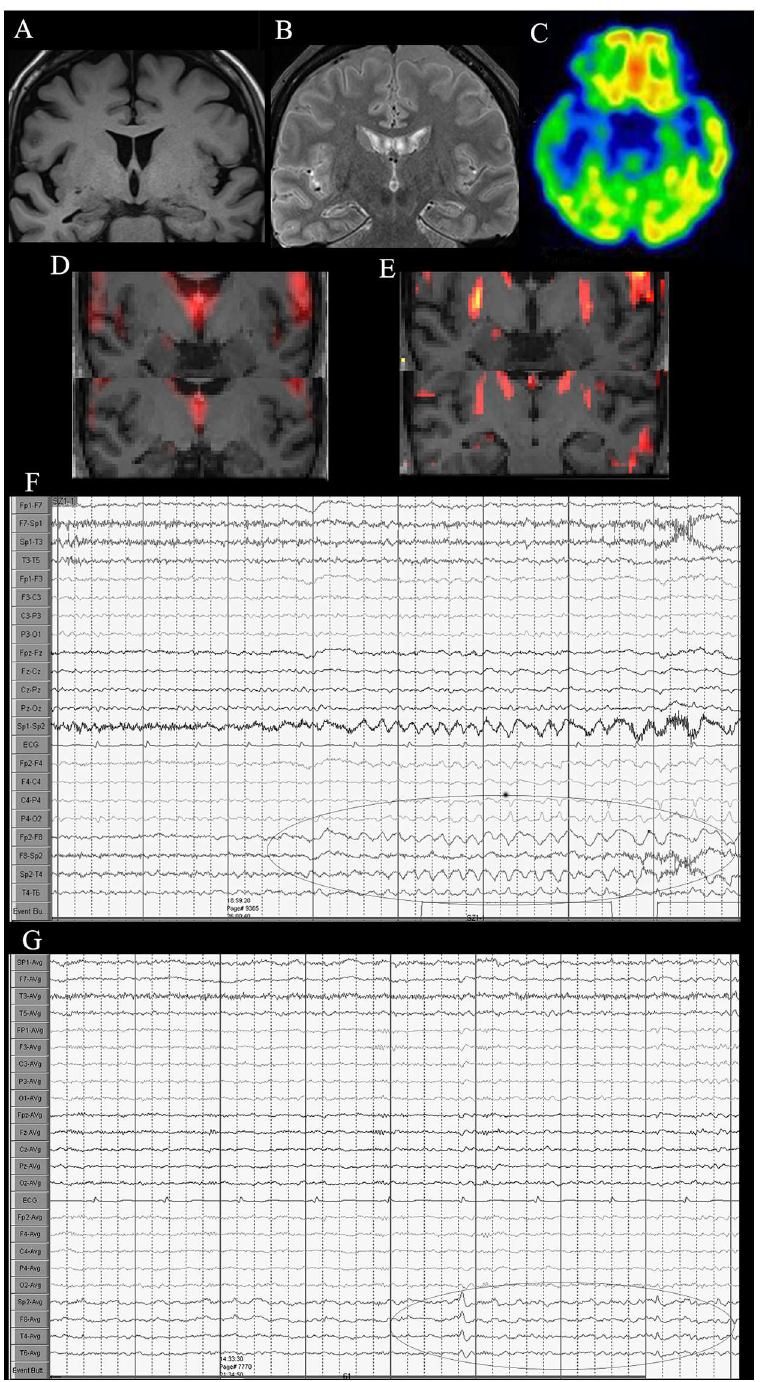
Fig 3. A 42-year-oldwoman diagnosed with right mesial temporal lobe epilepsy. (A) Coronal T1-weighted image showingright hippocampus atrophy, (B) FLAIR image showingslightly high signal of right hippocampus. (C) 18 F-FDG PET/CT imagingreveals low FDG uptake in the left temporal lobe region, particularly, in the hippocampus. (D) CoronalALFF and (E) ReHoreveal abnormalactivationin the right hippocampus comparedto the left side. (F, G) VEEG showingictal and interictal discharges in the right